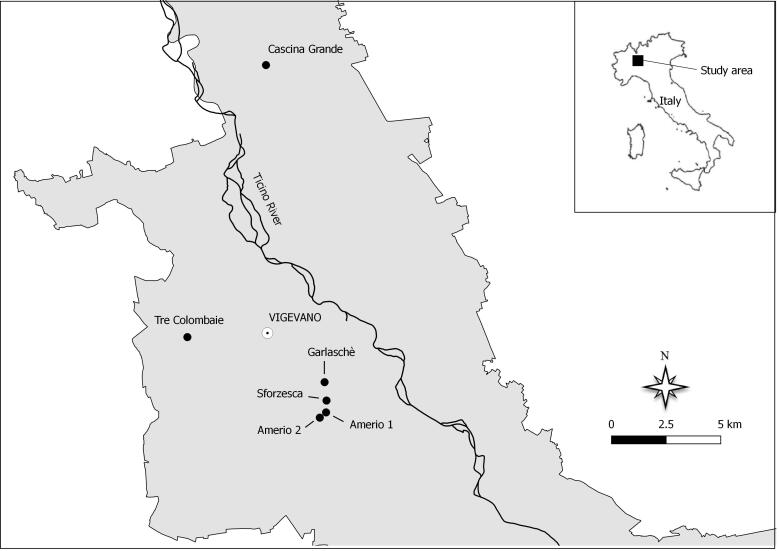
The six marcita fields in north-western Italy. In grey, the boundaries of the Ticino Valley Regional Park (Lombardy area) and, in black, the Ticino River.